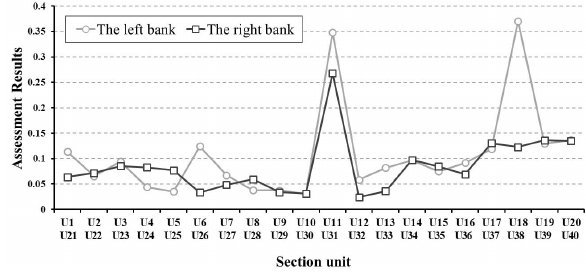
Fig. 9. Comparison of the flood risk between the left and right